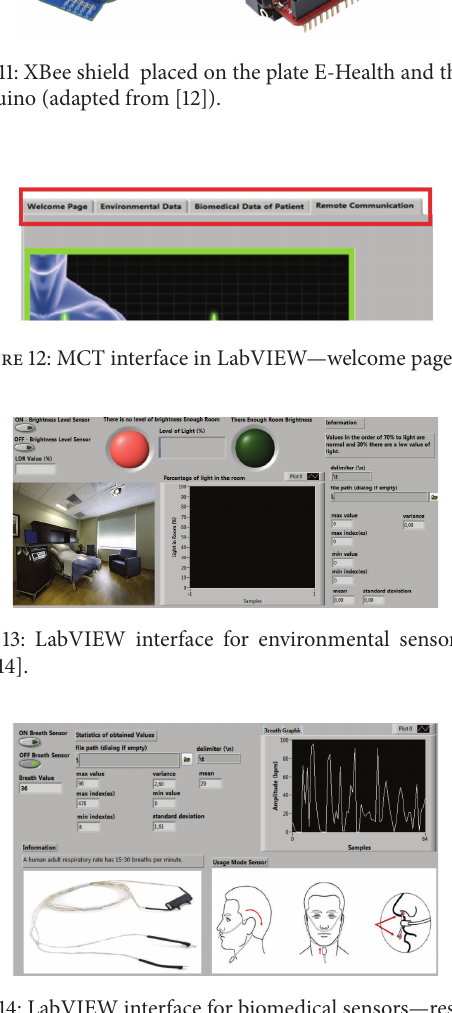
Figure 14: LabVIEW interface for biomedical sensors—respiration sensor [14].